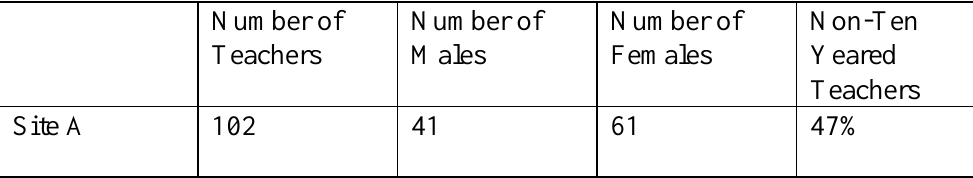
Faculty Characteristics at the High School